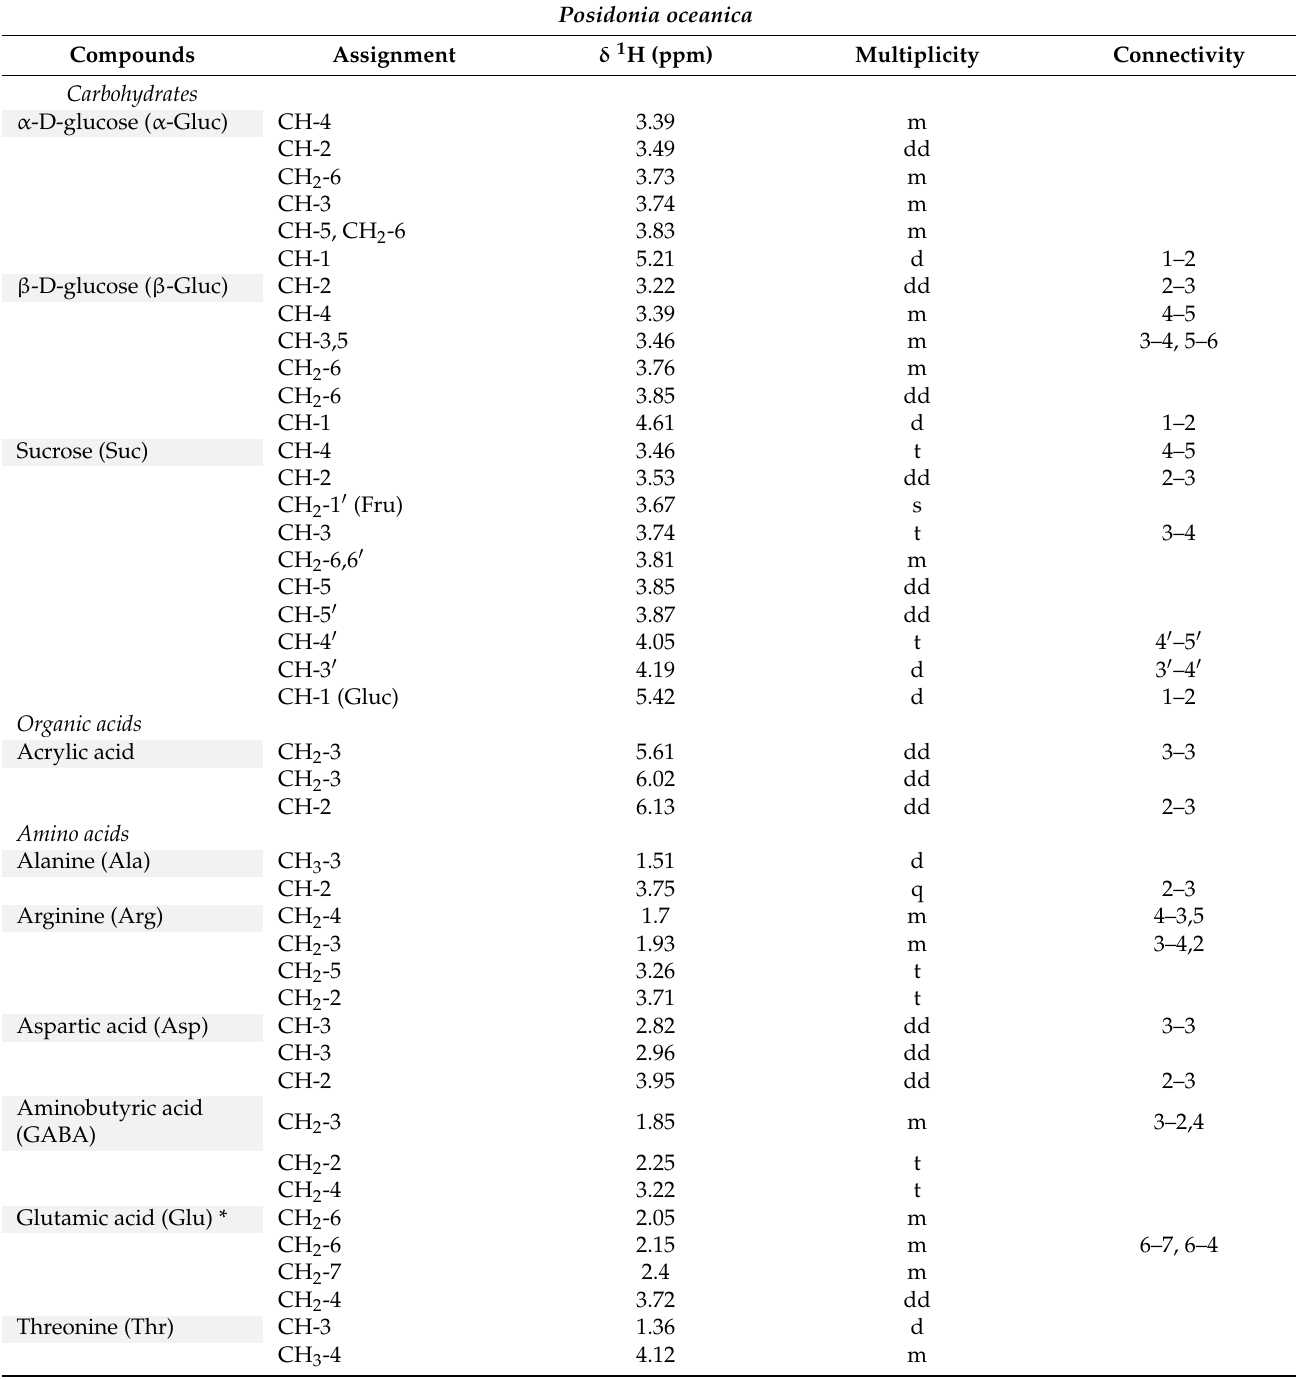
Table 4. Summary of the metabolites identified in the 600 MHz 1 H-NMR spectrum of the alcoholic extracts of Posidonia oceanica and Ascophyllum nodosum . * Chicoric acid: specifically identified in the leaves and in small quantities in the